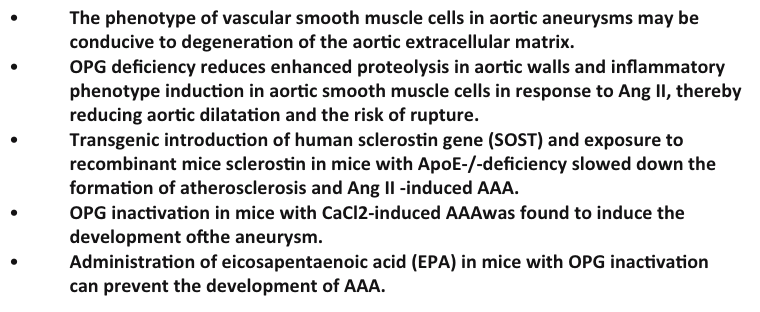
Figure 2: Drug - induced modulation of OPG